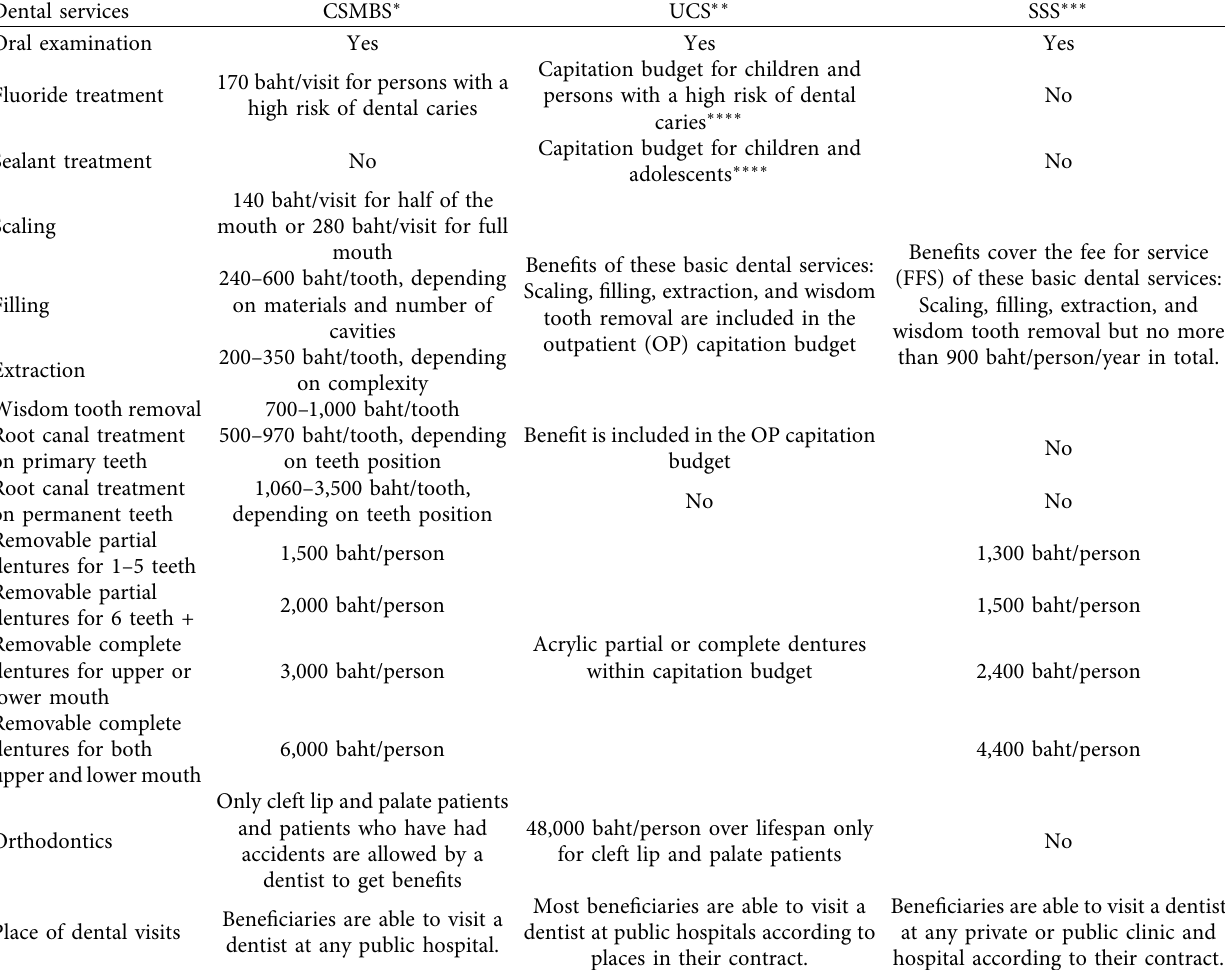
Table 1: Differences of dental benefits coverage among 3 health insurance